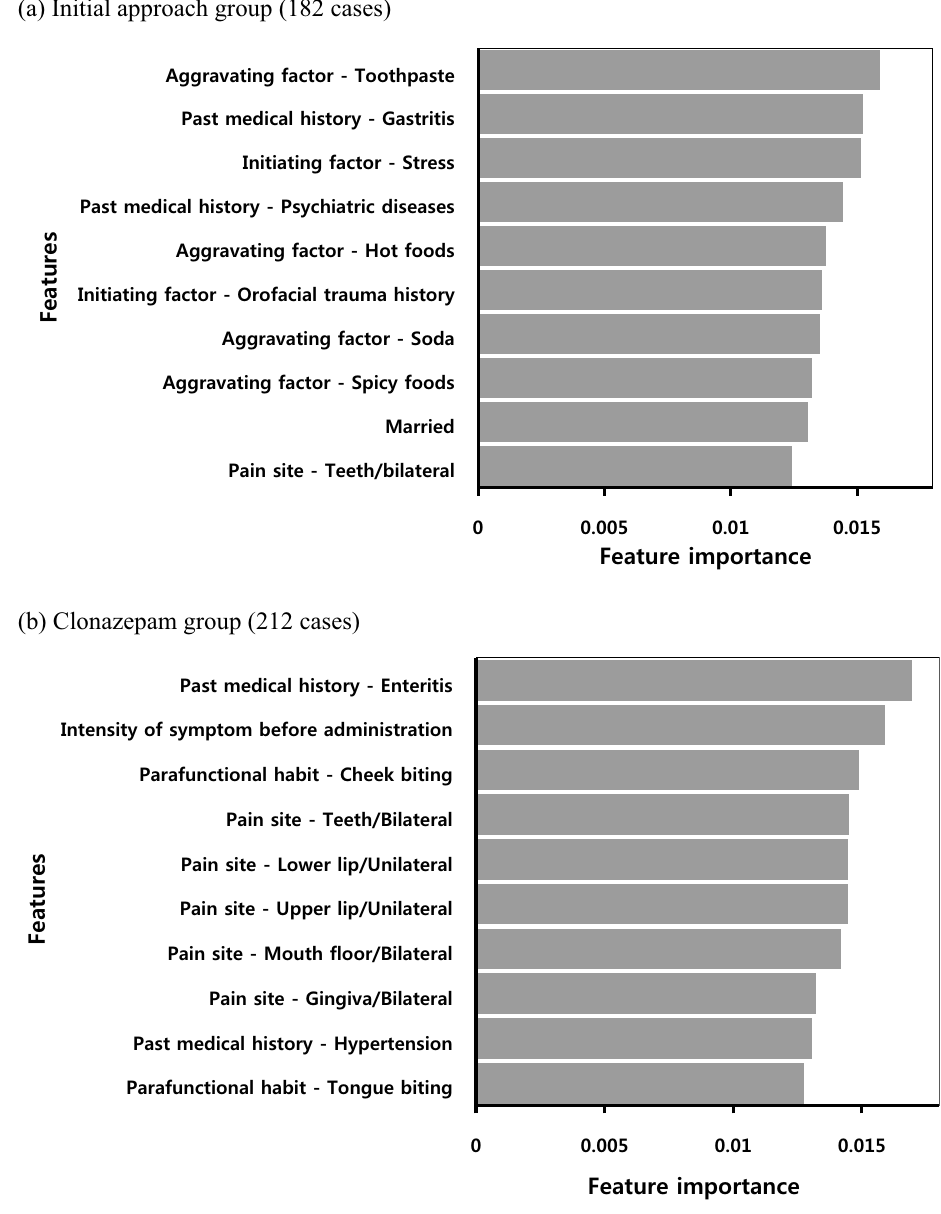
Figure 2. Top 10 feature importance for prediction models of ( a ) the initial approach and ( b ) clonazepam group